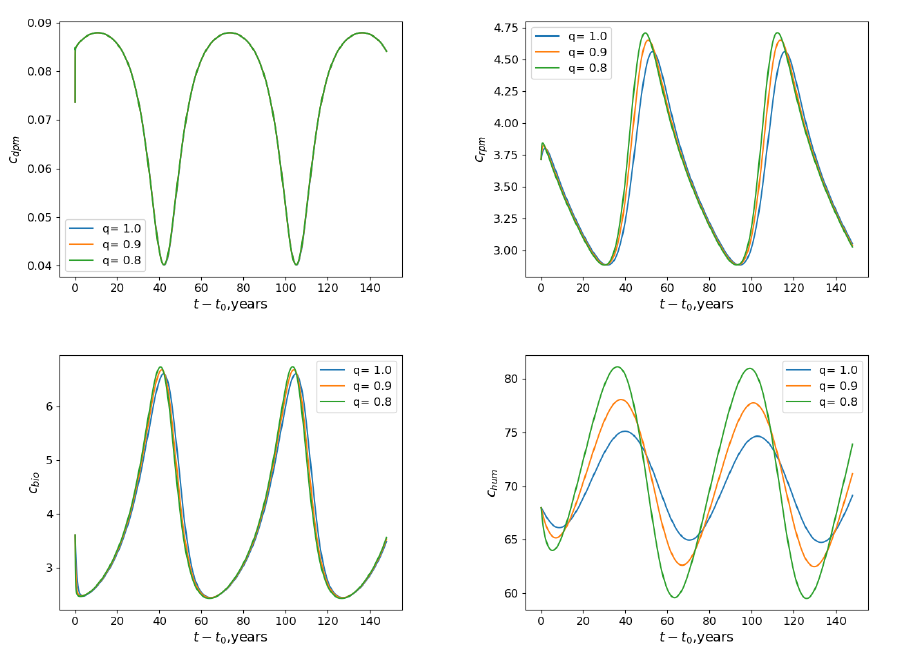
Figure 2. From the top-left cell following the left-to-right direction: the numerical solutions c dpm , c rpm , c bio , c hum with respect to t − t 0 for h = 0.02 in the case of periodic inputs ( ζ ( t , q ) = t q − 1